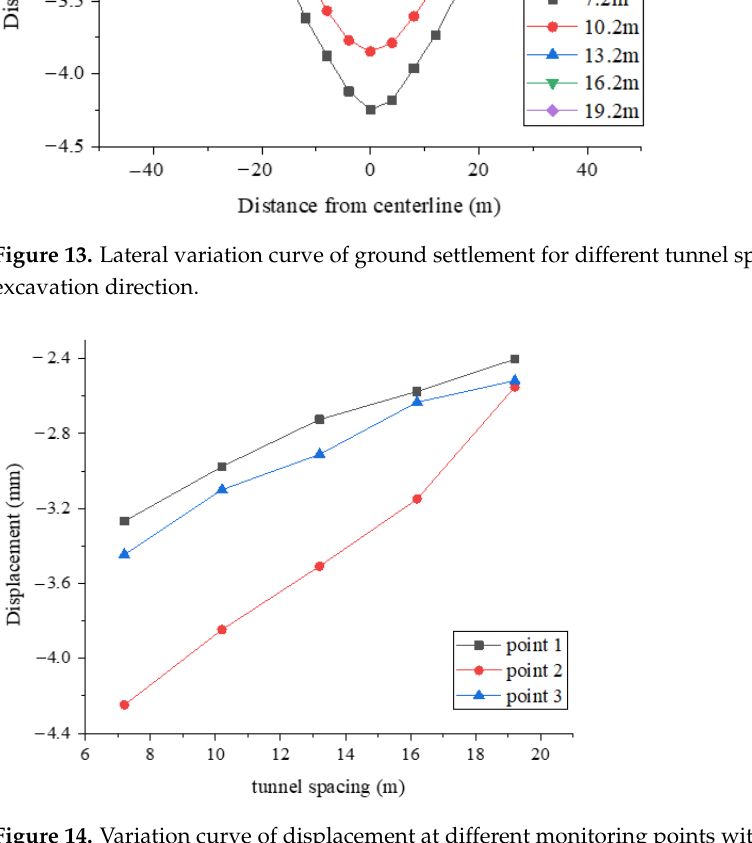
Figure 14. Variation curve of displacement at different monitoring points with the tunnel spacing.